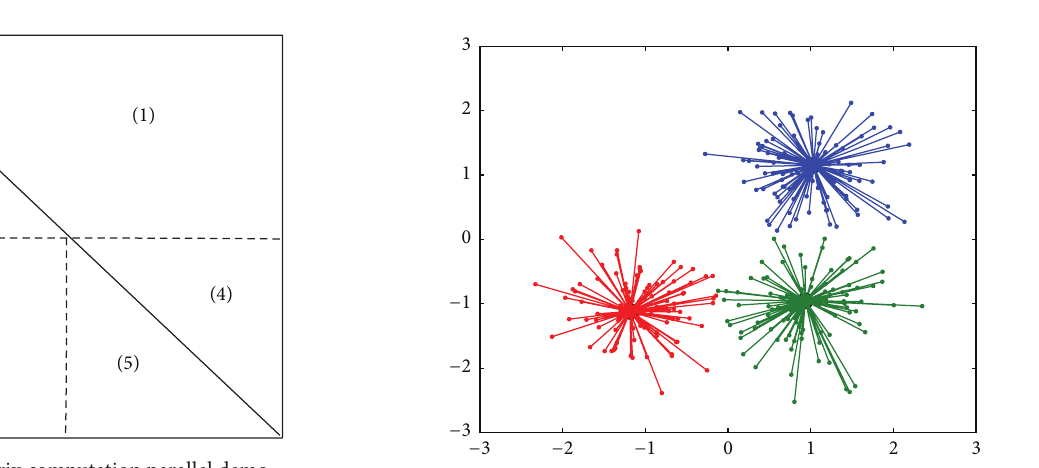
Figure 6: Matrix computation parallel demo.